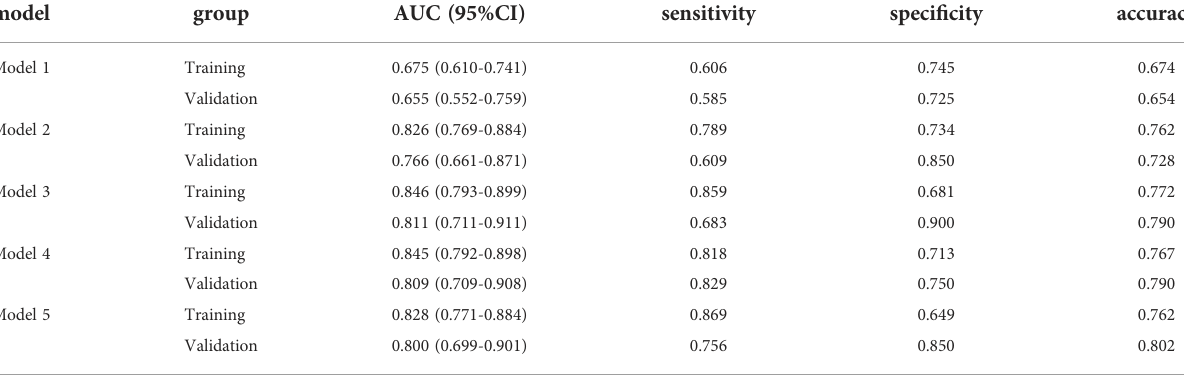
TABLE 3 ROC curves of the training dataset and the validation